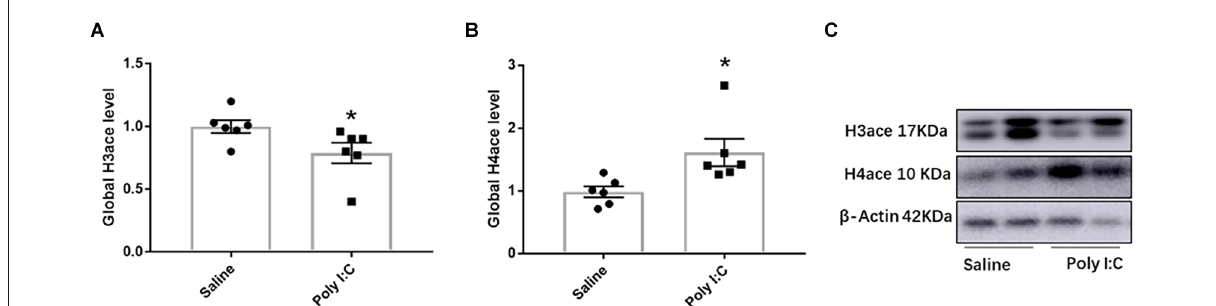
FIGURE1 Effect of prenatal Poly I:C exposure on the global level of H3ace and H4ace in the prefrontal cortex of female juvenile rats. (A) H3ace, (B) H4ace, and (C) representative Western-blotting images. Data were presented as mean ± SEM ( n = 6/group). The molecular weights of H3ace, H4ace, and Actin are 17 kDa, 10 kDa, and 43 kDa, respectively. * p < 0.05, Poly I:C vs. Control.